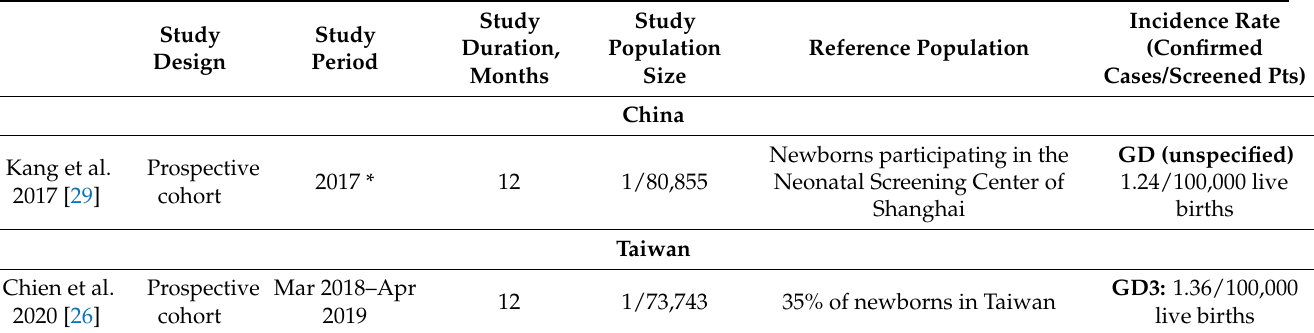
Table 5. GD incidence: Asia-Pacific region.